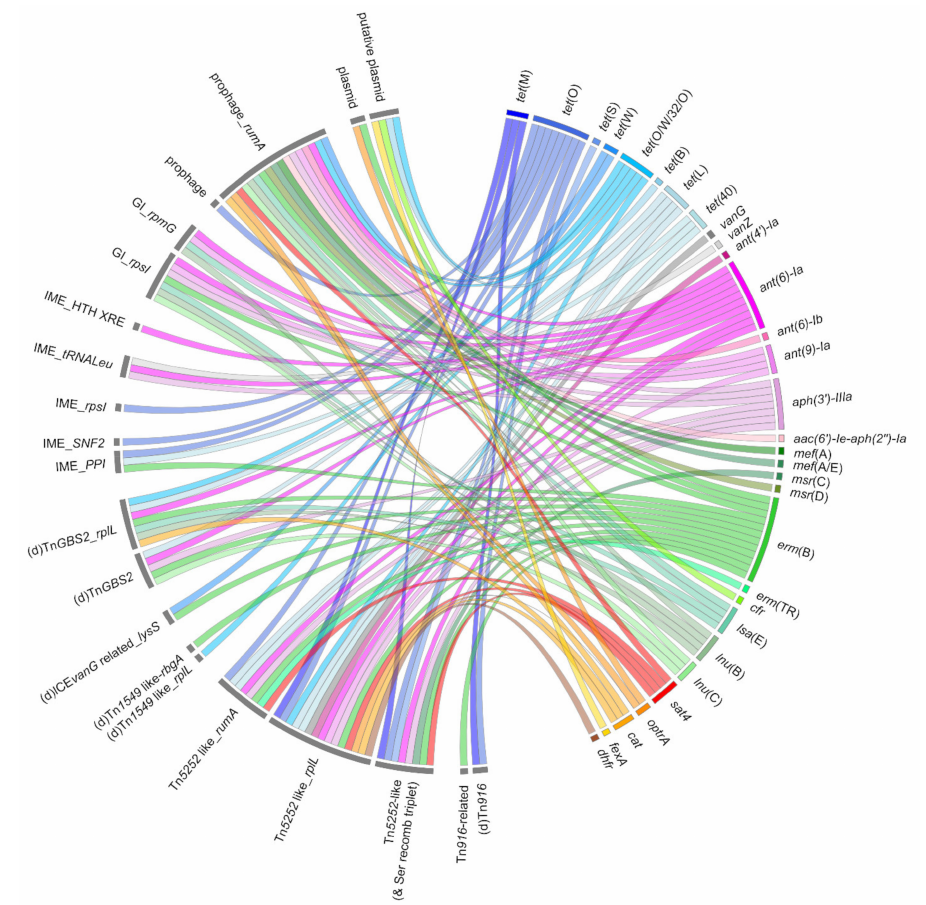
Figure 3. Mobile genetic elements carrying resistance genes described in Streptococcus suis . Ribbons indicate the association between resistance genes ( appearing in the right panel ) and mobile genetic elements ( on the left panel ). The color code used to distinguish the different resistance genes is the same as for Figures 1 and